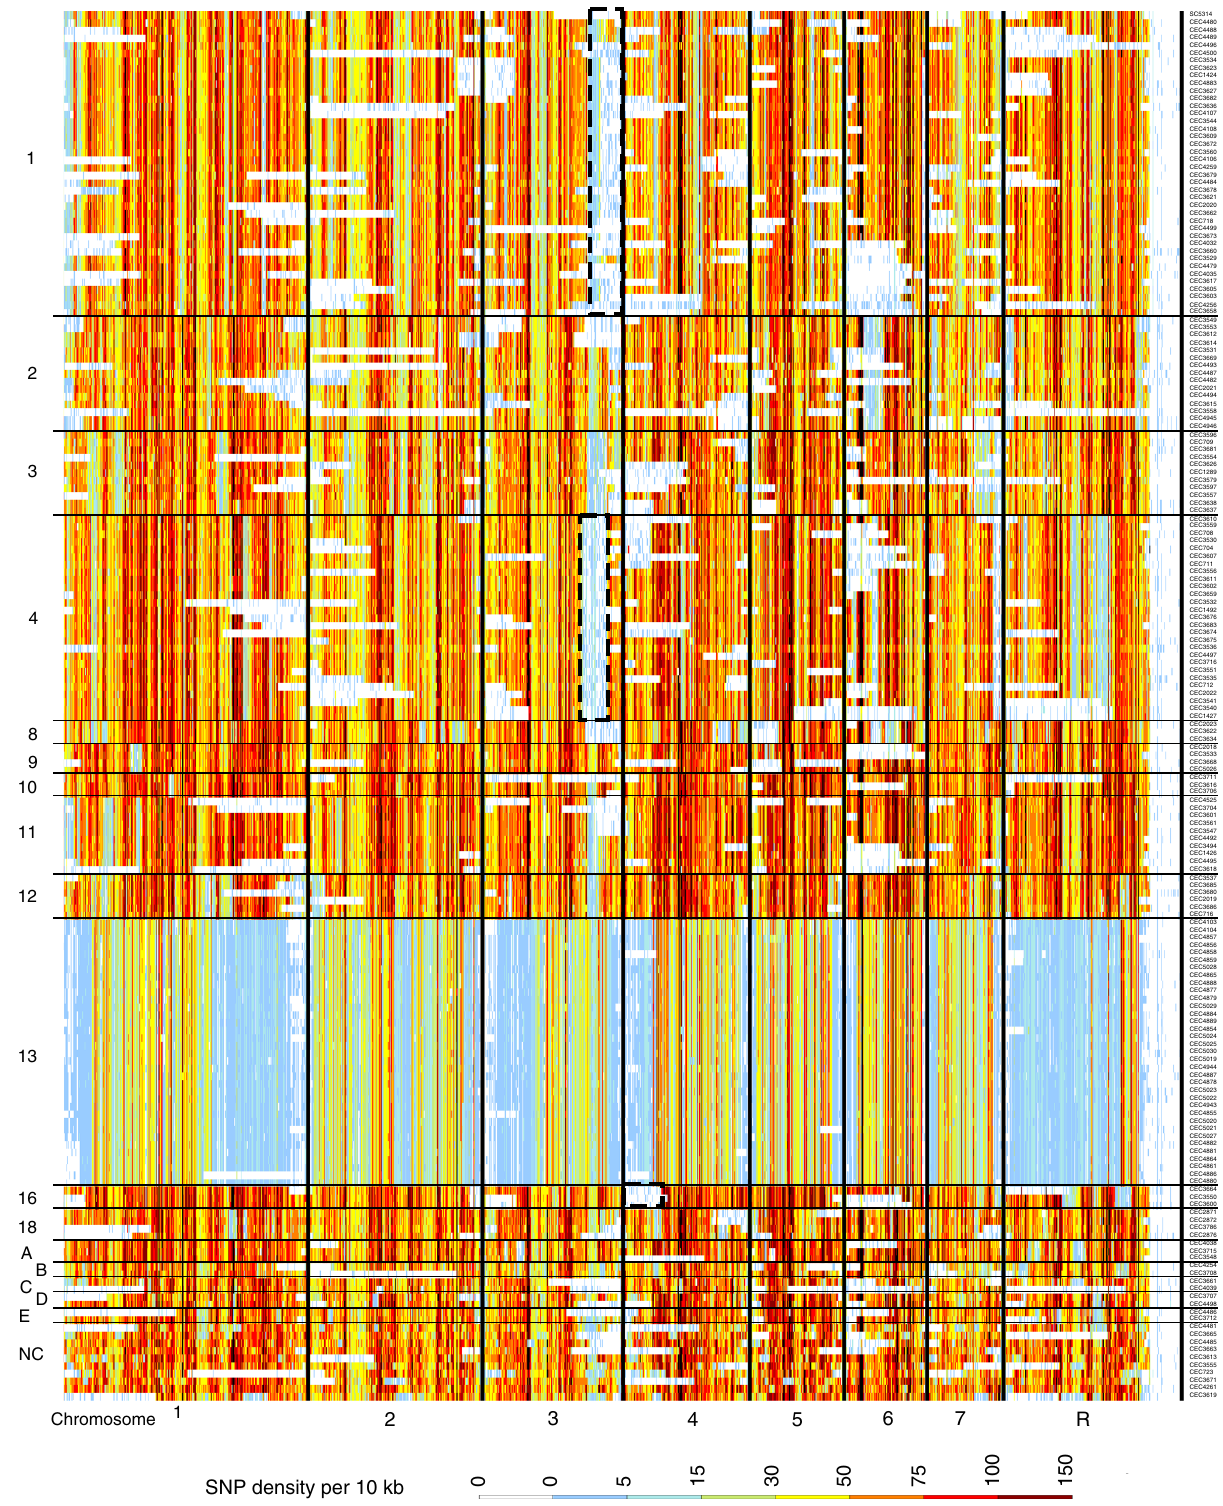
Fig. 1 Density of heterozygous SNPs in 182 C. albicans isolates, in 10 kb windows. Each row represents a strain. Strains are ordered according to their cluster assignation. Thick vertical black lines delimit chromosomes (from 1 to 7 and R). Dotted black boxes highlight examples of ancestral LOH shared by all isolates of a cluster. Horizontal white stripes are indicative of recent LOH events. The scale bar represents density of heterozygous SNPs per 10 kb window, from a low density in light blue (white for 0) to a high density in dark